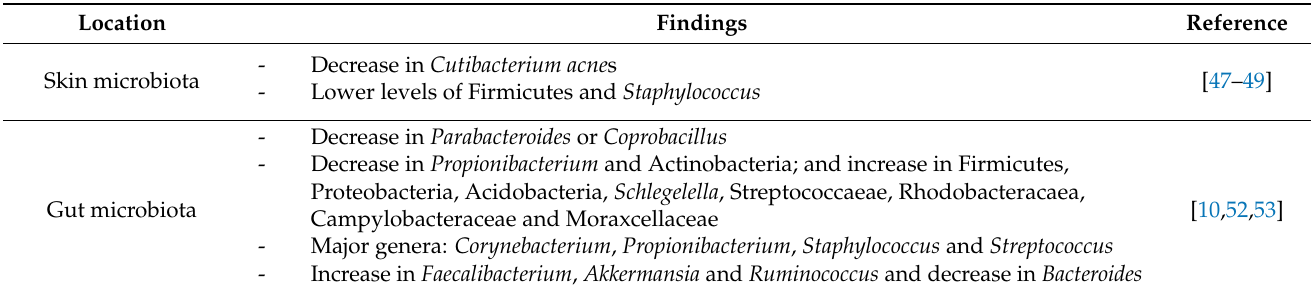
Table 2. Microbiota and